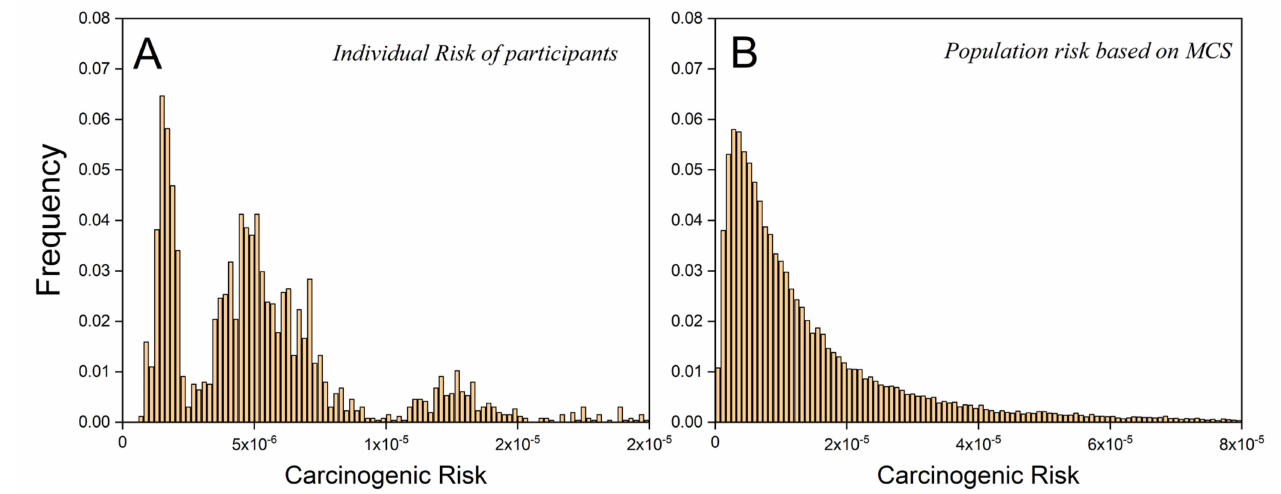
Figure 4. Risk distribution obtained by ( A ) individual assessment and ( B ) traditional assessment model based on MCS.